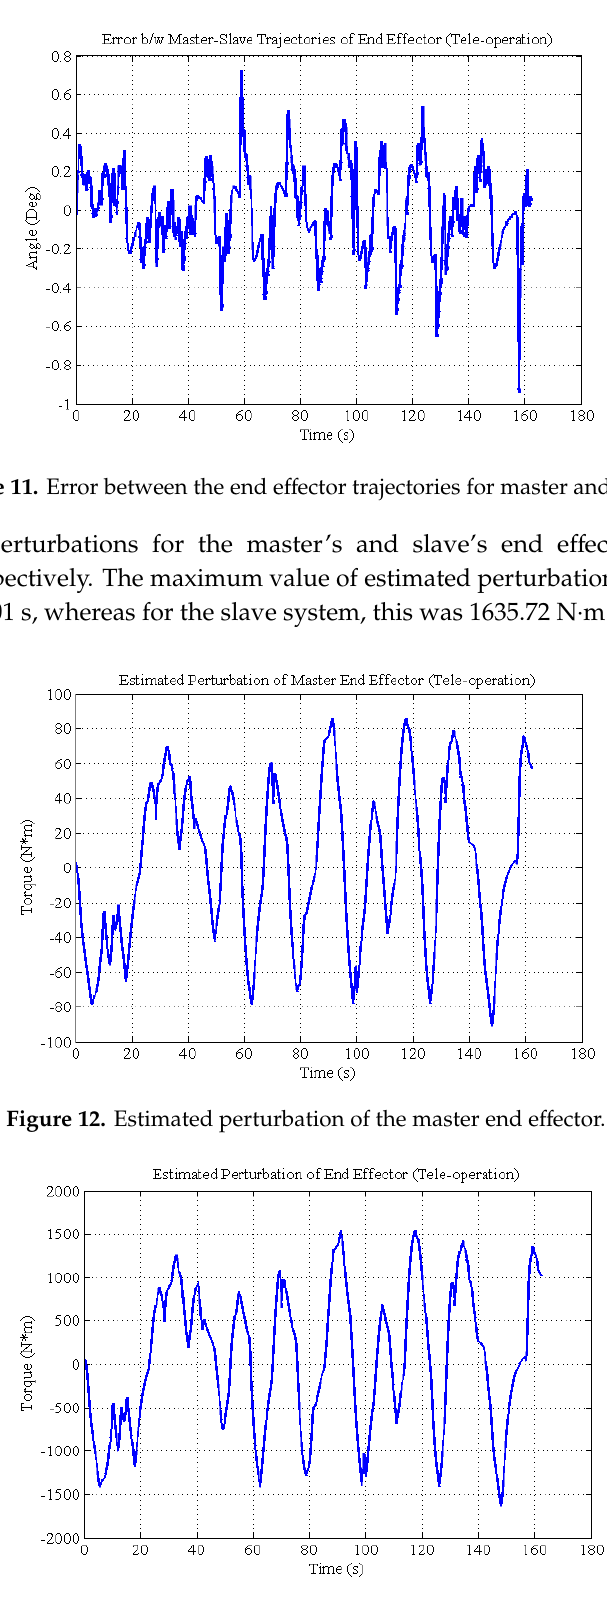
Figure 13. Estimated perturbation of the slave end effector.